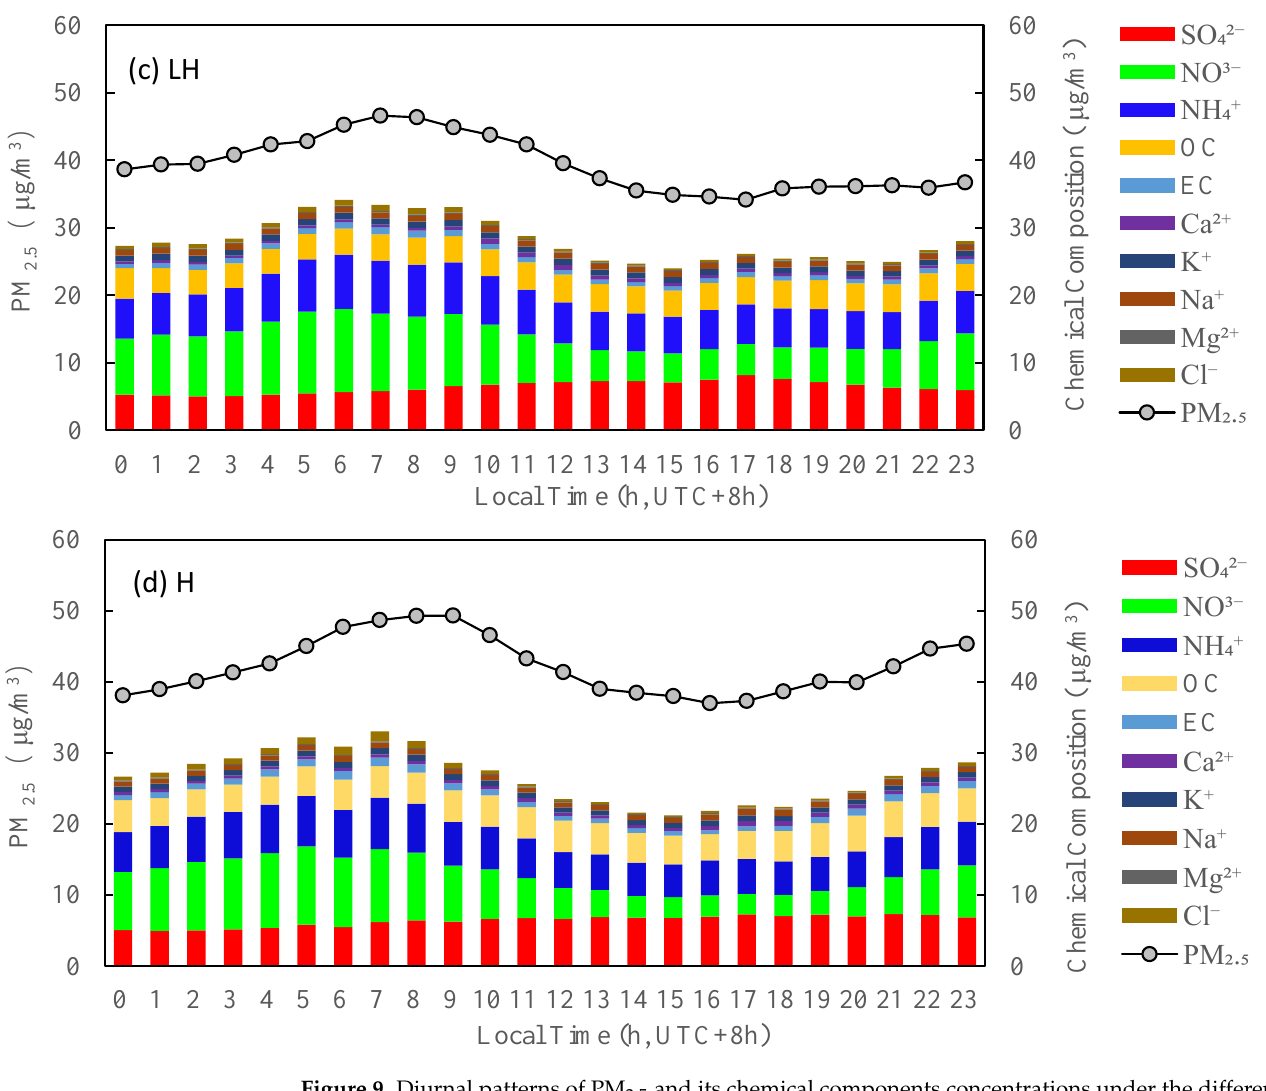
Figure 9. Diurnal patterns of PM 2 . 5 and its chemical components concentrations under the different photochemical activity levels, in summertime 2020 in Tianjin, China. ( a – d ) denotes the different photochemical activity levels of L, M, LH and H.